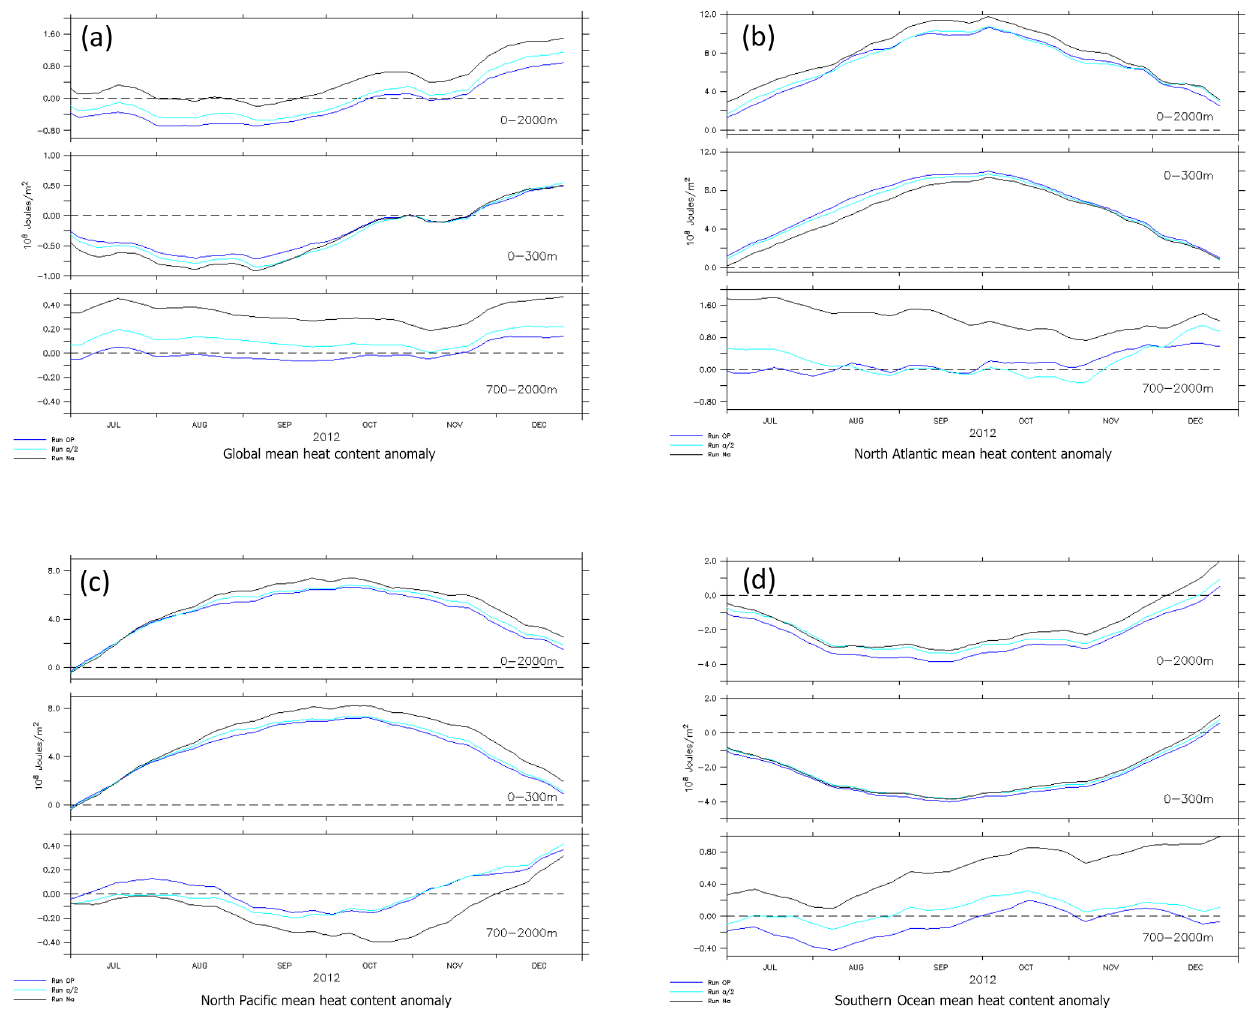
Figure 8. Heat content anomaly time series for the 0–2000, 0–300 and 700–2000m layers of the Run-Ref (blue), Run-Argo2 (light blue) and Run-NoArgo (black): (a) for the global ocean, (b) North Atlantic, (c) North Pacific and (d) Southern Ocean.